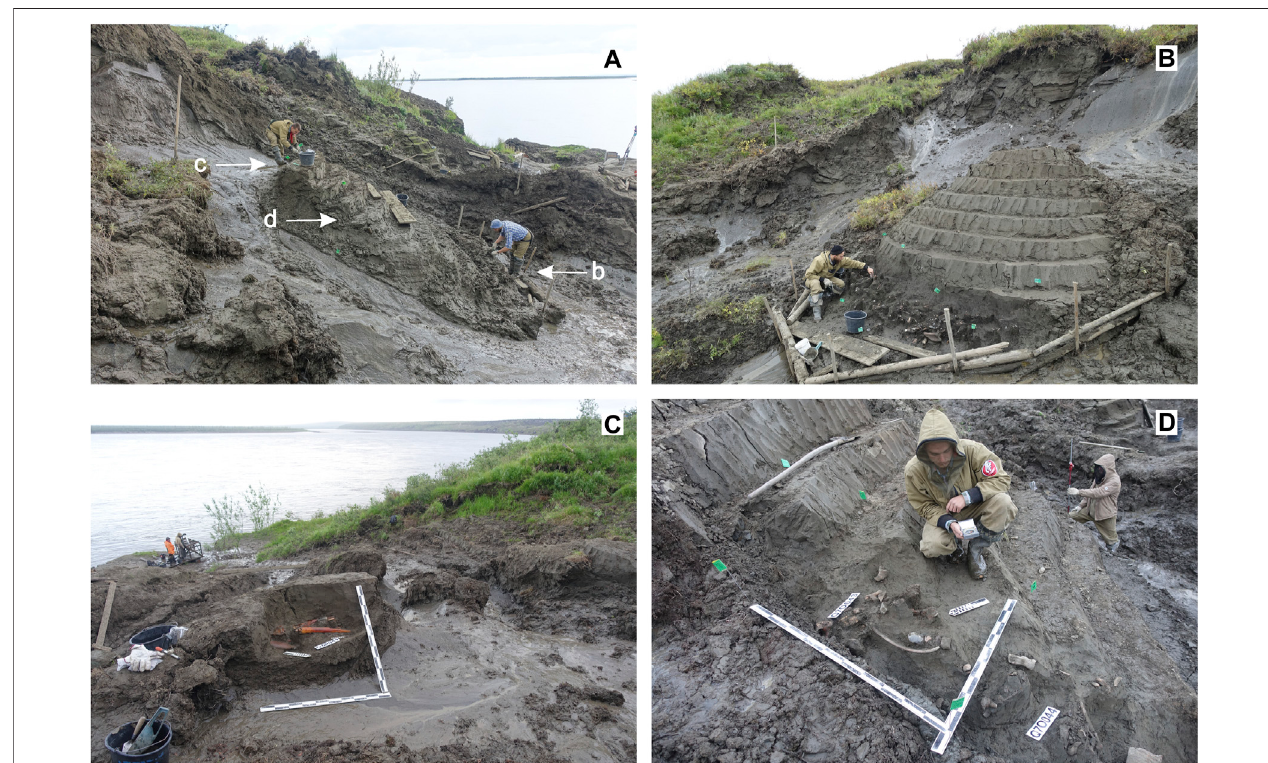
FIGURE10| Spatialandhypsometricdistributionoftheculturallayerobservedindifferentpartsofthesamepermafrostpolygonrevealedbytheexcavationsatthe Yana B area in 2017: (A) polygon with cultural horizon viewed from the West, arrows indicate locations of b, c, and d photographs documenting different parts of polygonalmound; (B) – subhorizontal position ofthecultural layerinthe middle partofthepolygon depositviewed fromtheEast; (C) portion ofthecultural layernearthe ice-wedgeborderintherearpartofthepolygonlays3 mhigherrelativetothesourcelevelshownina,viewfromtheNorth-East; (D) narrowstripoftheculturallayer bended up near the polygon margin, view from the